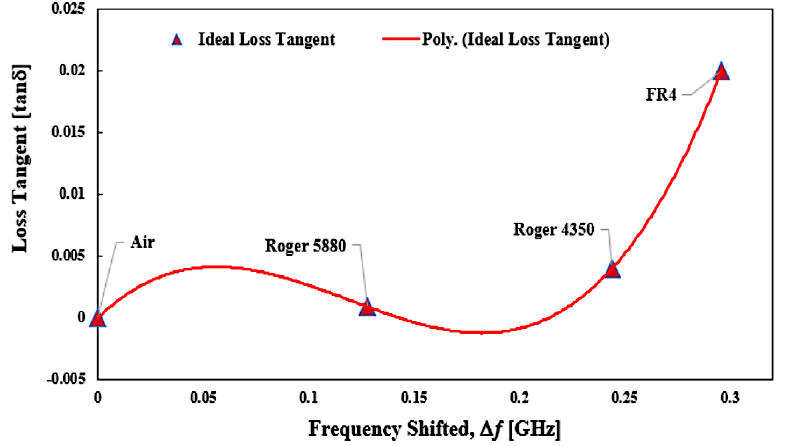
Figure 18. Polynomial fit of loss tangent for SUTs.